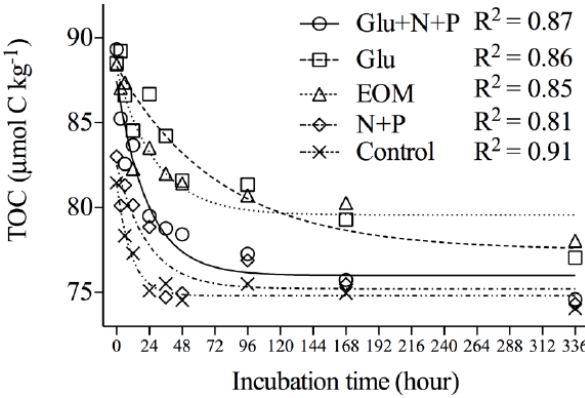
Figure 3. Variations of TOC concentrations during the incubation time course of various treatments. The non-linear regression lines were obtained from the corresponding TOC concentration observa- tions during the entire incubation. Symbols shown in the figure are the mean values of TOC concentrations at each sampling